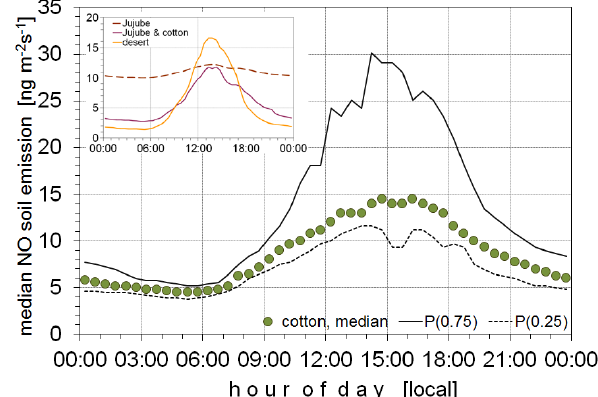
Figure 4. Median diel variation of the actual NO-flux (ng m − 2 s − 1 ; in terms of mass of nitric oxide) from soils of the four major land- cover types of Milan oasis for the period 3–24 June, 2011. Data have been calculated according Eq. (10) using (a) soil temperatures (medians) measured for each of the four major land-cover types, and (b) so-called “wilting point” data for corresponding soil moisture contents at the four sites (see Sect. 2.2.3). Data for the cotton site are given as medians, as well as 25 and 75% quantiles, and those for the Jujube, Jujube-cotton and desert sites as medians only (see figure